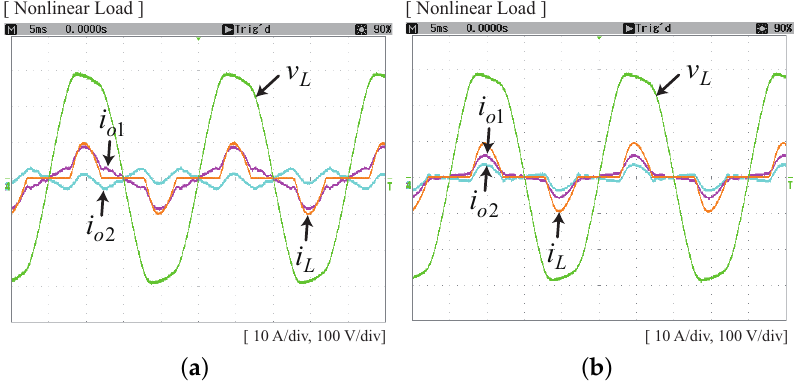
Figure 10. Controlled local AC bus voltage and output current waveforms in a nonlinear load condition: ( a ) conventional droop method; ( b ) proposed active impedance